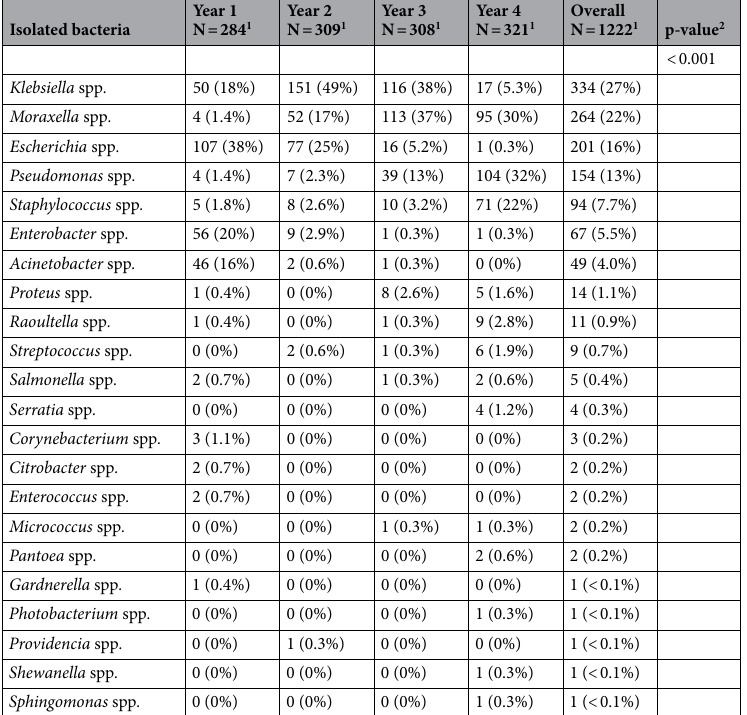
Table 2. Bacteria isolated from the TZPHRL during the study period. 1 n (%); 2 Pearson’s Chi-squared test.